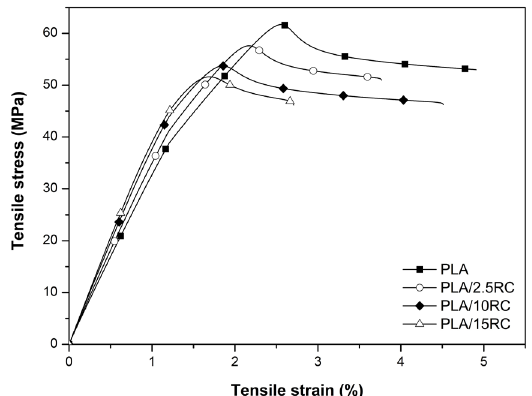
Figure 3. Stress-strain curves for PLA and PLA/RC